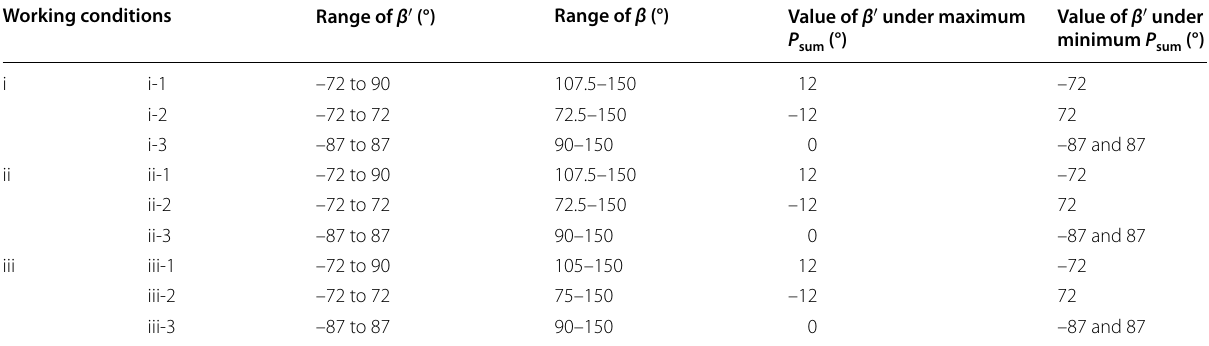
of lower power consumption P i-j